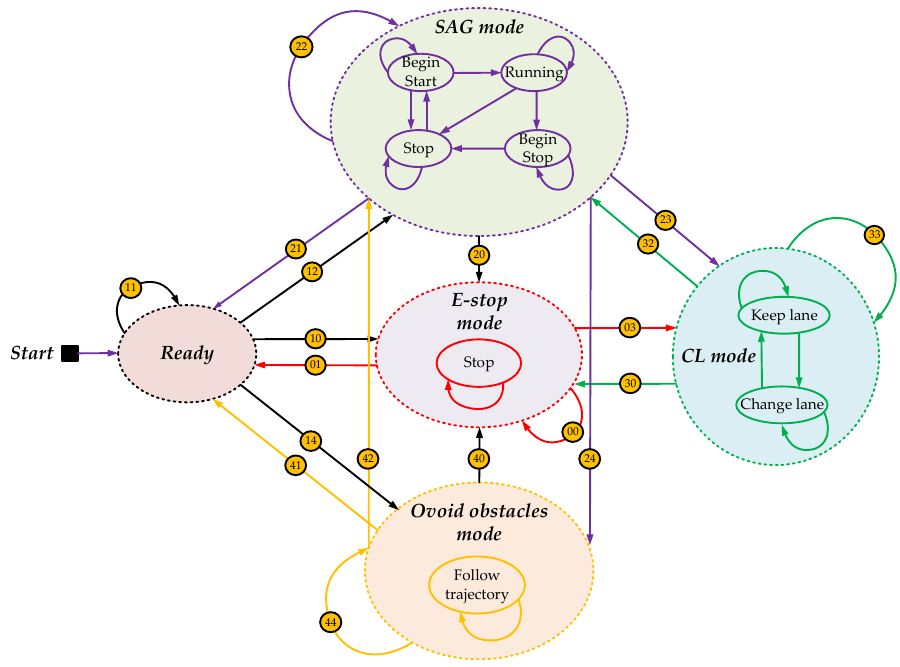
Figure 2. Decision mechanism based on Mission-Finite State Machines (M-FSM) while the inside of M-FSM describes Control FSM